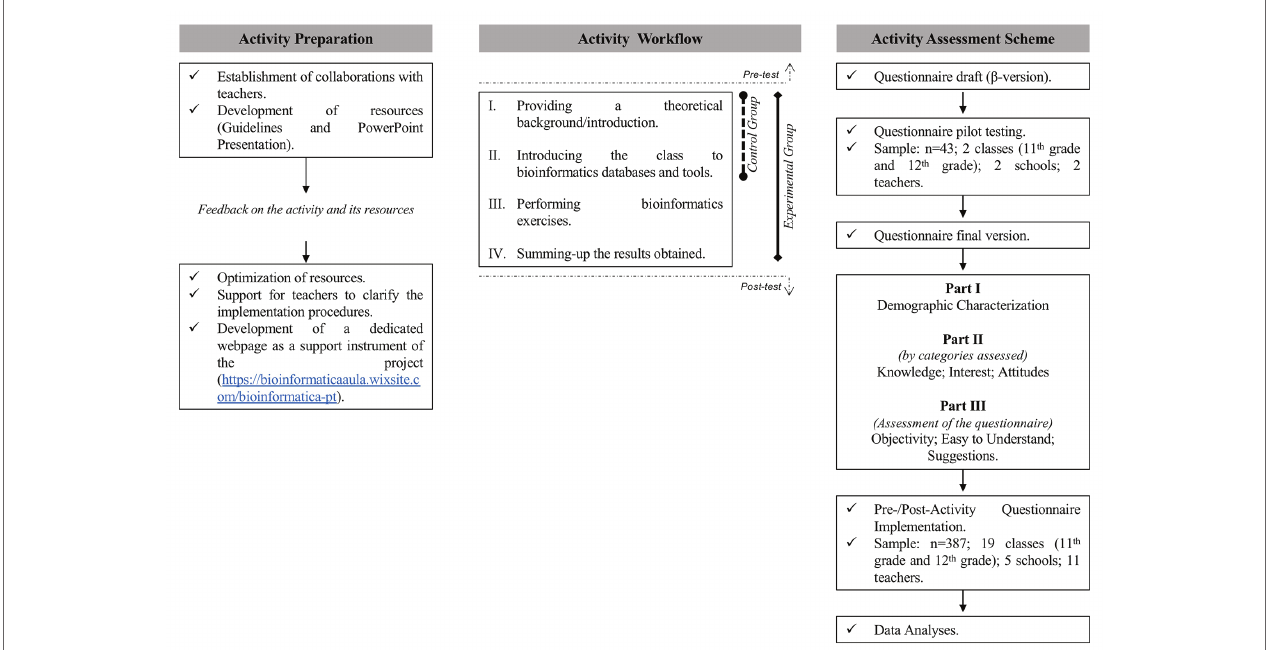
FIGURE 2 | Experimental design for preparation, implementation, and assessment of bioinformatics-based